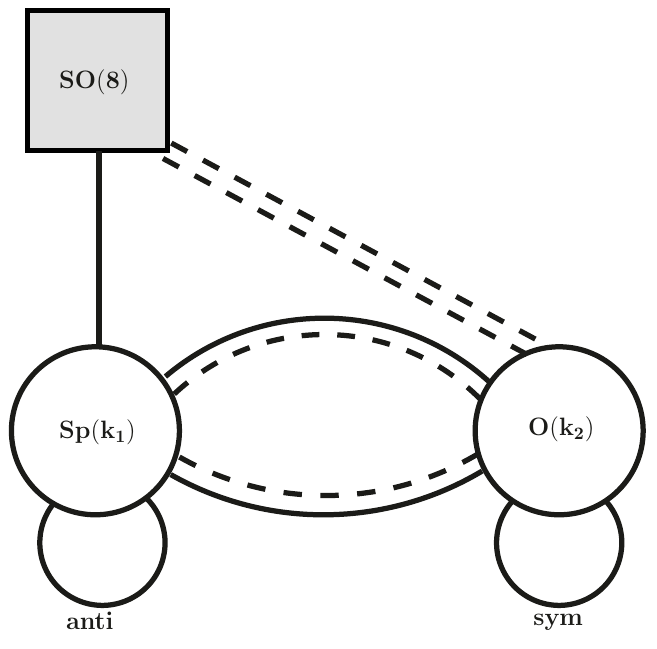
Figure 3 . Quiver for one instanton on D 4